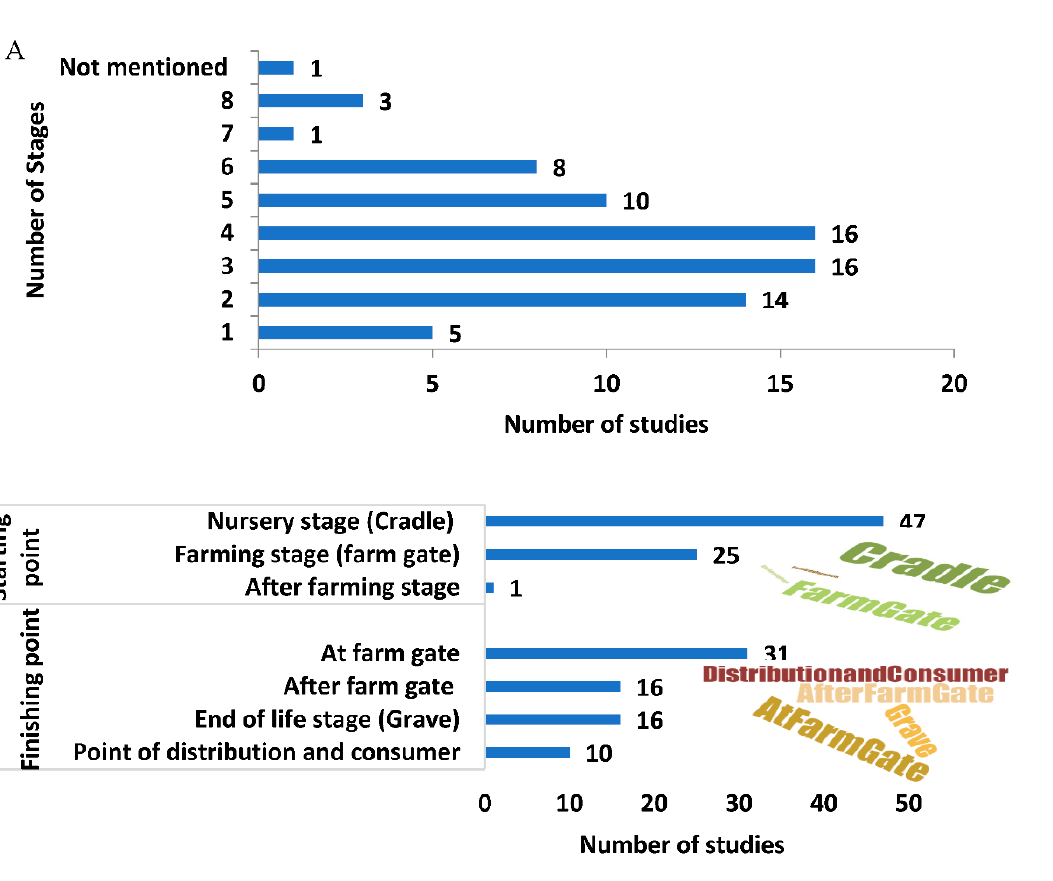
Figure 8. ( A ) Number of stages included in the systems obtained from the literature; ( B ) quantitative and qualitative illustration of the starting and ending points of the included stages as boundaries.